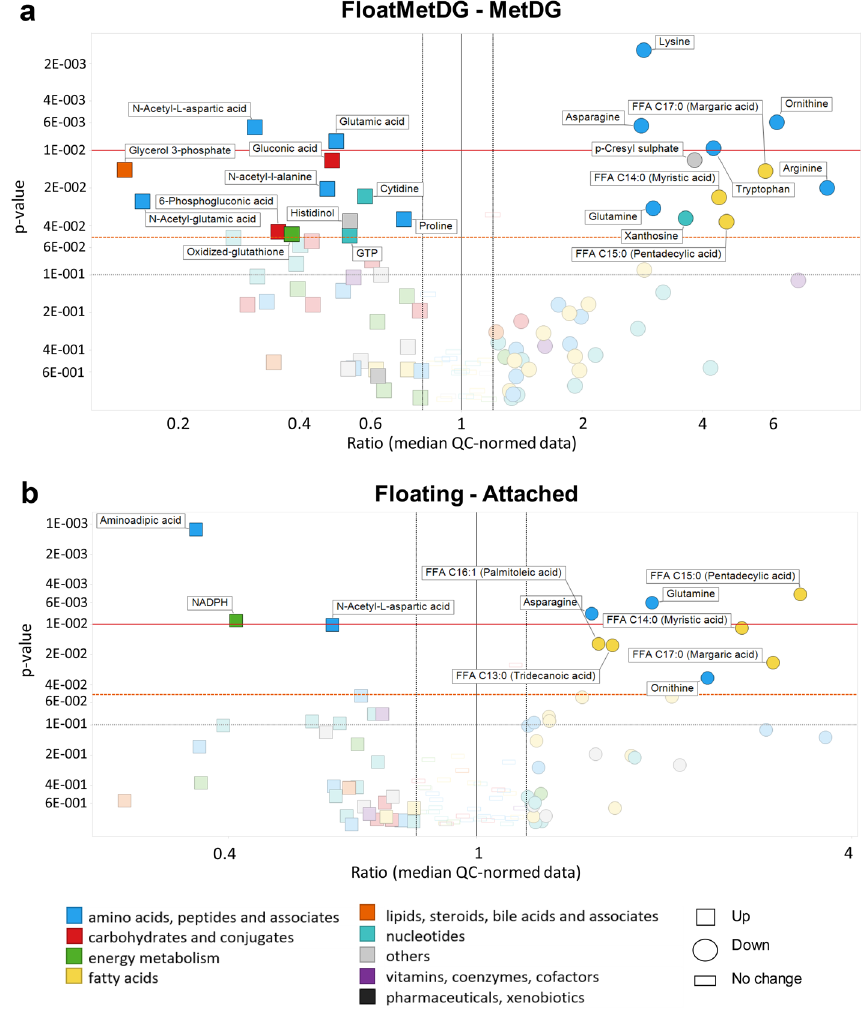
Figure 4. Metabolic differences between floating and attached cell populations for FloatMetDG versus MetDG ( a ) or overall floating versus attached cells ( b ). Metabolites on the left side of the black line were increased while those on the right side of the black line were decreased in FloatMetDG compared to MetDG ( a ) or overall in all floating compared to all attached cells ( b ). Y-axis: p values (inverse log-scale); x-axis: metabolite ratios (median QC normalized data, log-scaled). Axis scale is different for ( a ) and ( b ) Left black dotted line (0.8)—ratio of 0.8; right black dotted line (1.2)—ratio of 1.2. The red horizontal line denotes a p value of 0.01, the orange line denotes a p value of 0.05 and the grey line denotes a p value of 0.1. Metabolites are colored according to the HMDB classes. Metabolites with p value bellow 0.05 and metabolite ratio > 1.2 or < 0.8 are named. Metabolites are marked with a square for increase and a circle for decrease in floating compared to attached